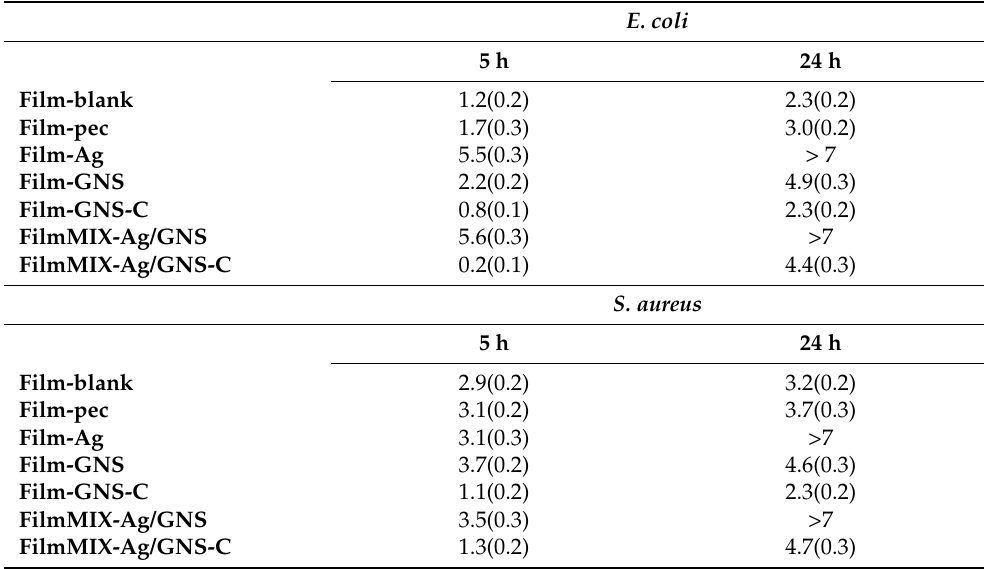
Table 2. ME at 5 and 24 h on planktonic E. coli and S. aureus 1